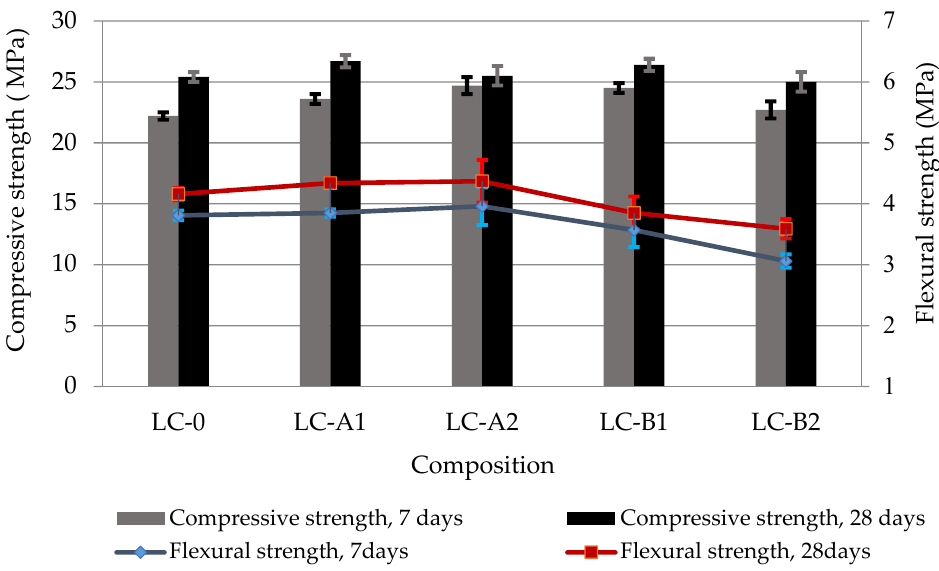
Figure 3. Compressive and flexural strength results of lightweight composites after 7 and 28 days of curing .